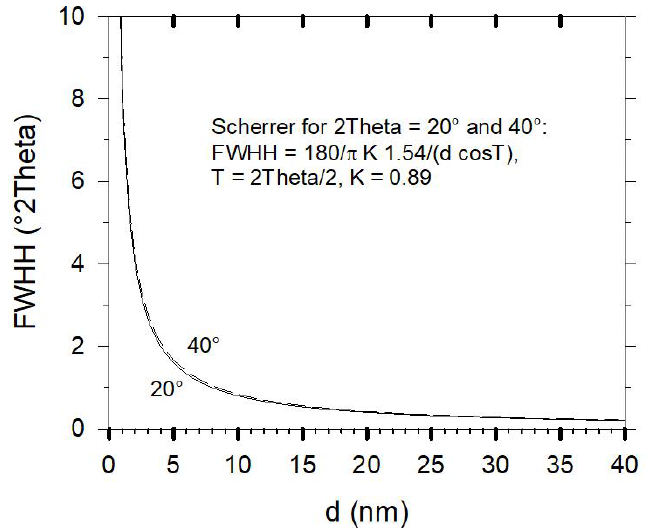
Figure 8. Plot of the Scherrer function for FWHH (full width at half height) of diffraction with CuKα1 at 20° and 40° 2Theta in the range d < 20 nm.